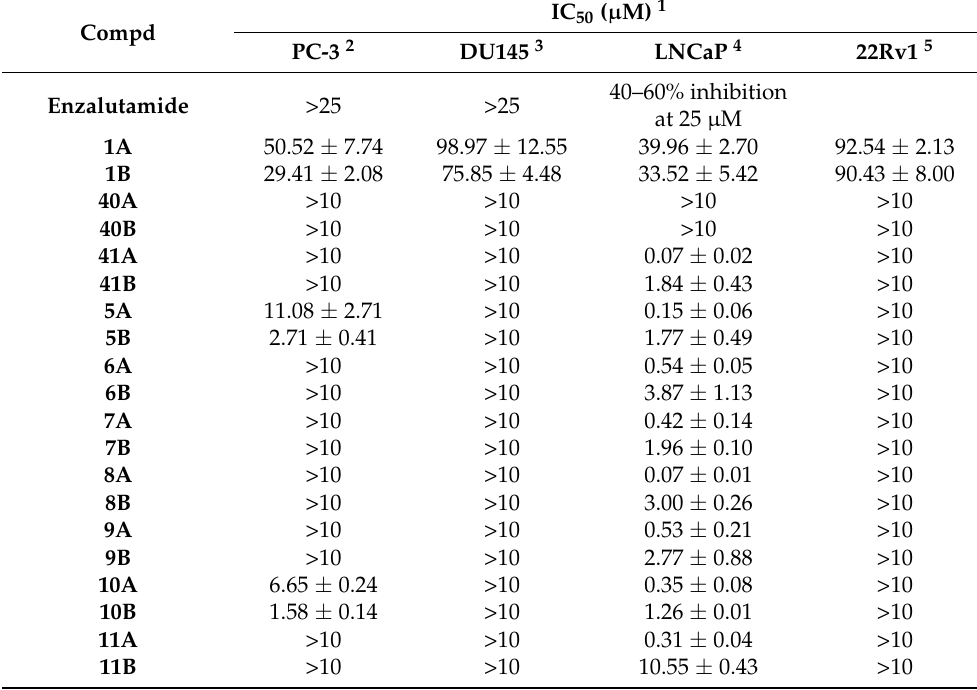
Table 6. Antiproliferative activity of optically enriched